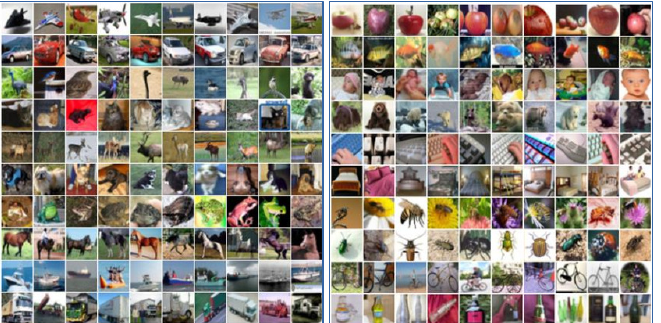
Figure 4. On the left are some sample images for each of the 10 classes of CIFAR-10 (one class for each row). On the right are 10 randomly selected classes from the set of 100 classes of CIFAR-100. Cub200 2011 [16] is a dataset that we use to face up the fine-grained classification problem (Figure 5). It contains 11,788 images of 200 species of birds split into 5994 and 5794 images for training and testing, respectively. Each image contains 15 part locations, 312 binary attributes, and 1 bounding boxes containing the bird within the image; however, we only used input images and their